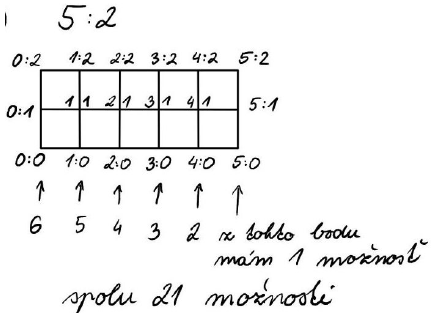
Figure 11. Analogy between task 3.2 and 3.3.